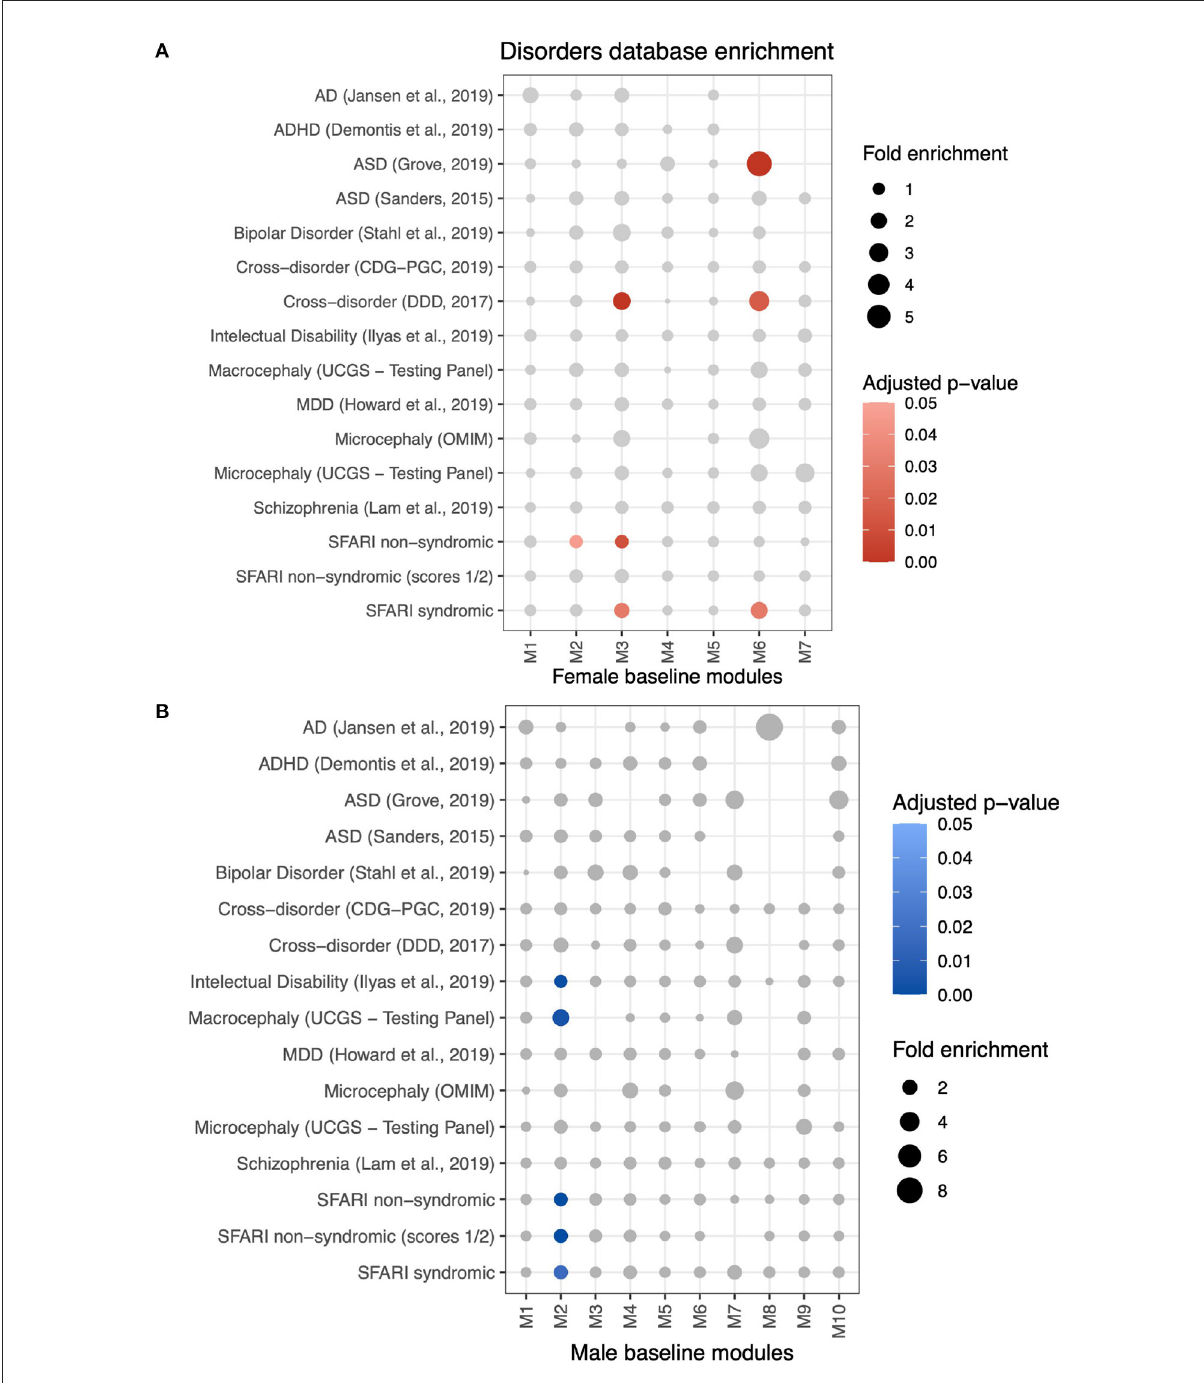
FIGURE6 Enrichment analysis using MSET to identify differential modules with genes associated with neuropsychiatric disorders lists from multiple databases (see Methods). (A) Disorders to which female-baseline differential modules are significantly enriched are represented by red scaled circles (adjusted p < 0.05). Circle size is relative to the fold enrichment. (B) Enrichment of male-baseline differential modules to disorders